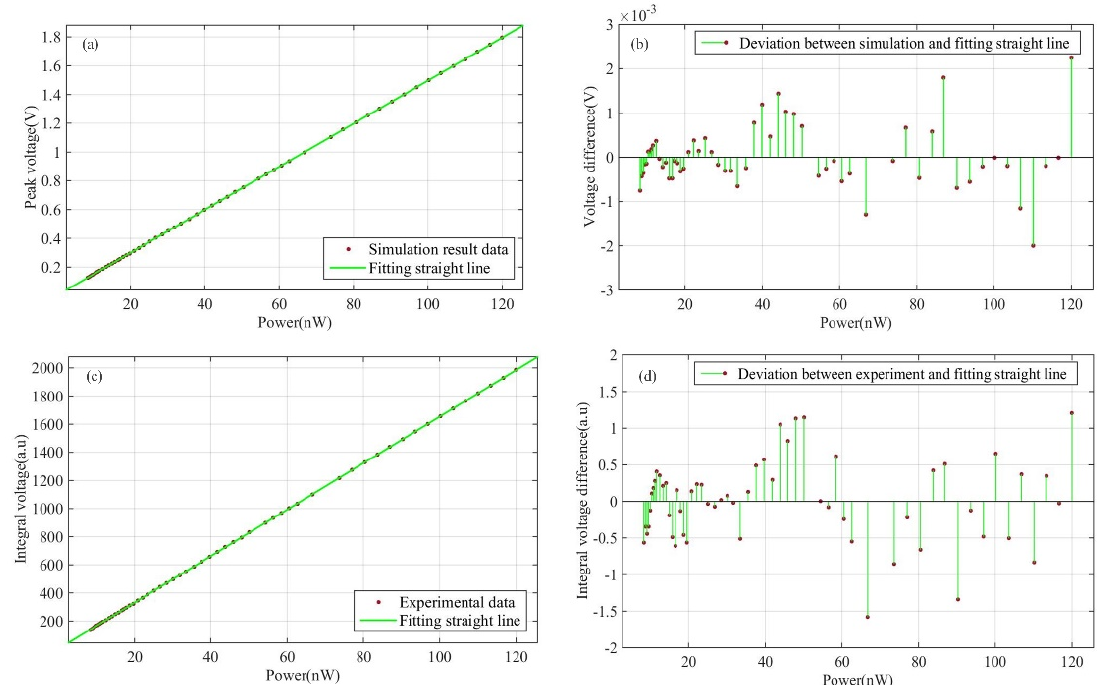
Figure 15. ( a ) Experimental data of output peak voltage of the optimized ACB varying with input power at magnification of 60 and its fitting straight line. ( b ) Voltage differences between experimental data and fitting straight line in Figure 15a. ( c ) Experimental data of output integral voltage of the optimized ACB varying with input power at magnification of 60 and its fitting straight line. ( d ) Integral voltage differences between experimental data and fitting straight line in Figure 15c.